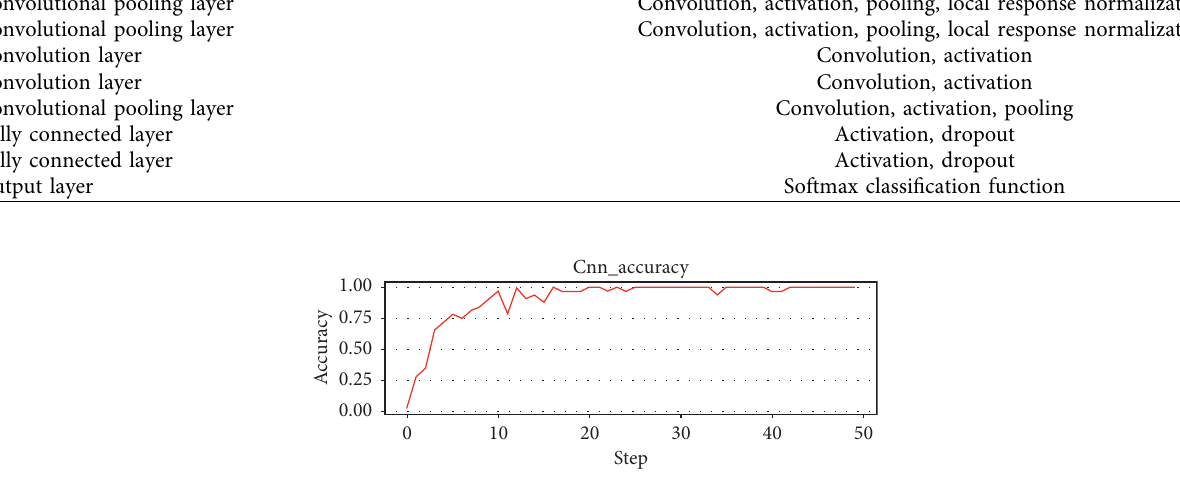
Figure 5: Change curve of success rate.